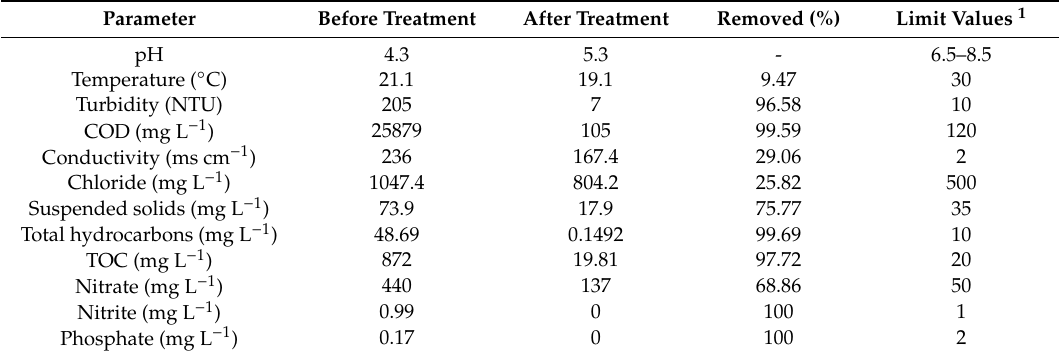
Figure 4. The influence of the initial pH on oily water photocatalytic degradation.